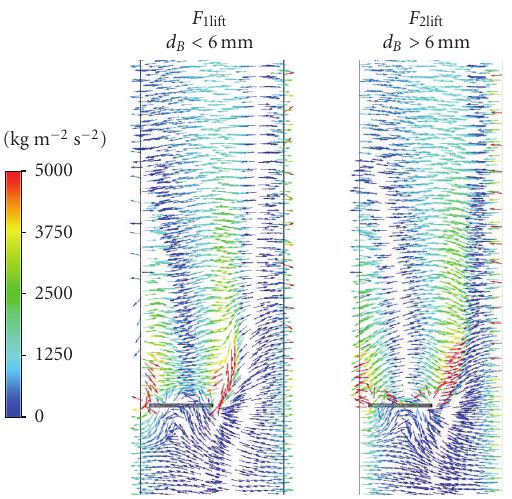
Figure 13: Bubble lift force vectors for the di ff erent gas velocity groups (run 096)